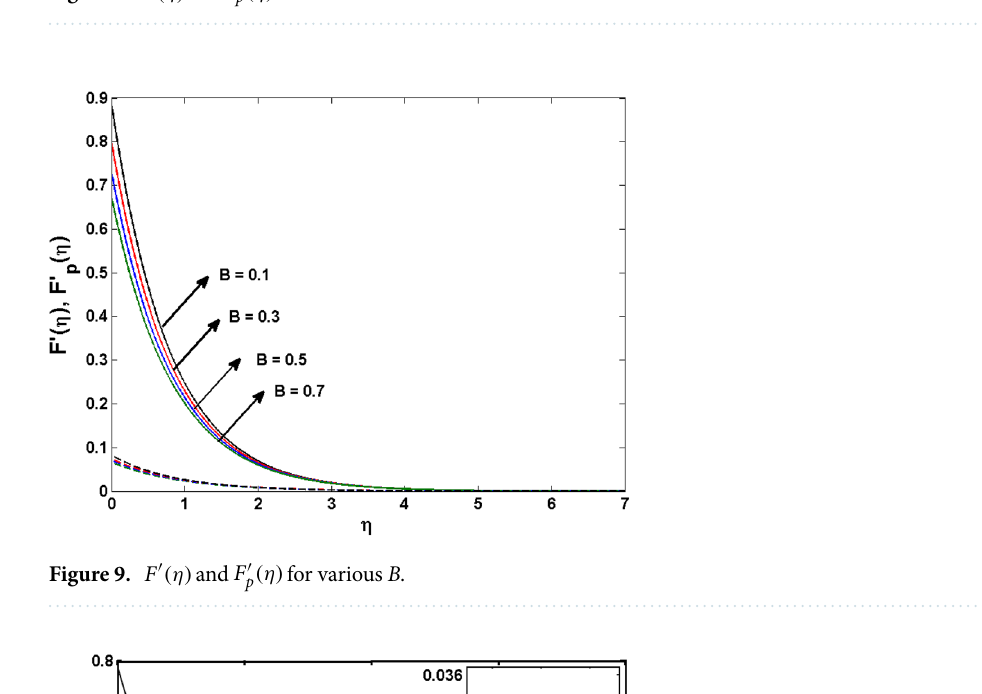
Figure 8. θ(η) and θ p (η) for various estimates of M .